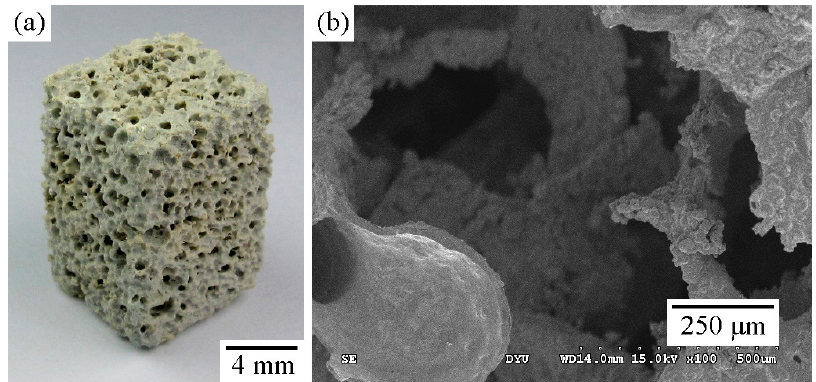
Figure 10. Photograph of a Ti foam air-sintered at 800 °C. The typical sample of the Ti foam ( a ), and SEM micrograph of the porous Ti ( b ).